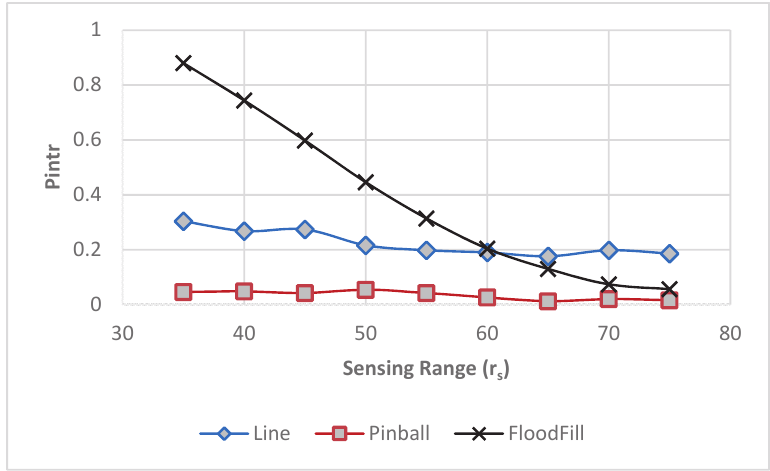
Figure 10. The escape probability ( P intru ) of an intruder that adopts the linear, pinball and flood-fill algorithms in a WSN with varying sensing range r s